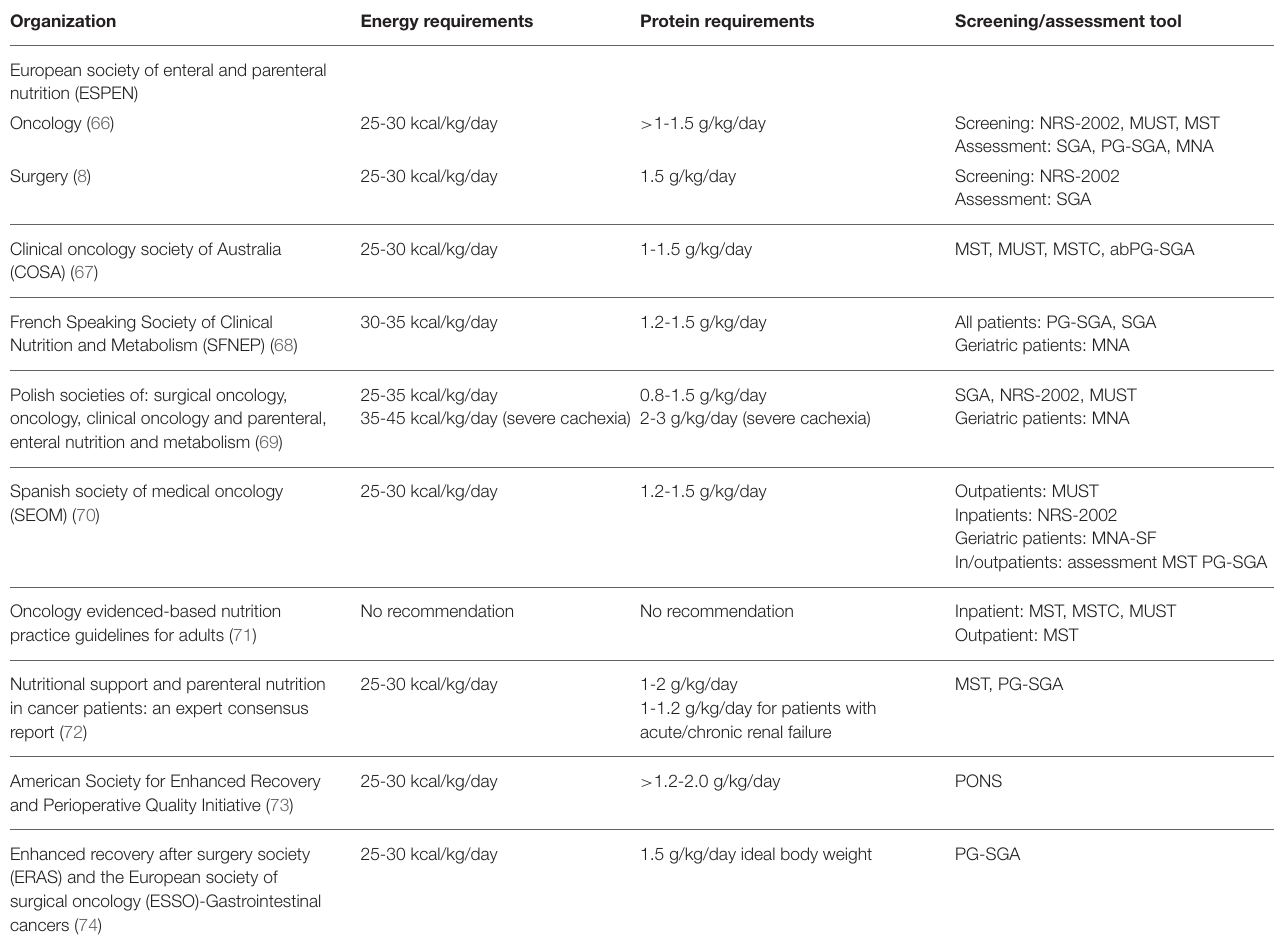
TABLE 2 | Clinical nutrition guidelines for surgery and/or oncology patients.